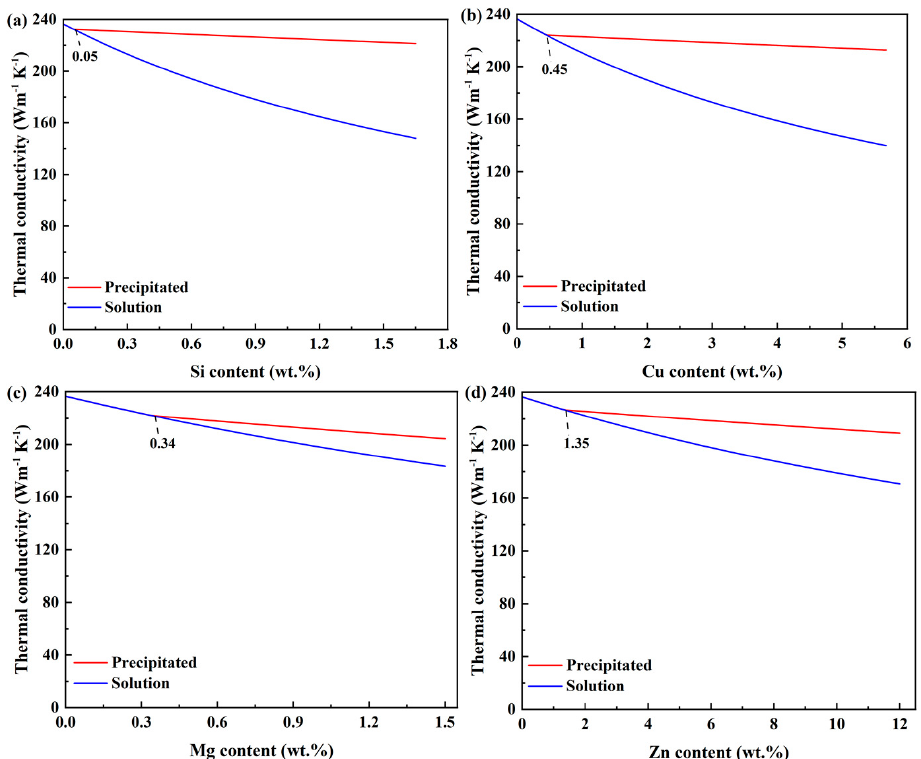
Figure 2. The relationships between the thermal conductivity of aluminum and the content of alloying elements in a solid solution and the precipitated state. ( a ) Al-Si, ( b ) Al-Cu, ( c ) Al-Mg, ( d ) Al-Zn [61].